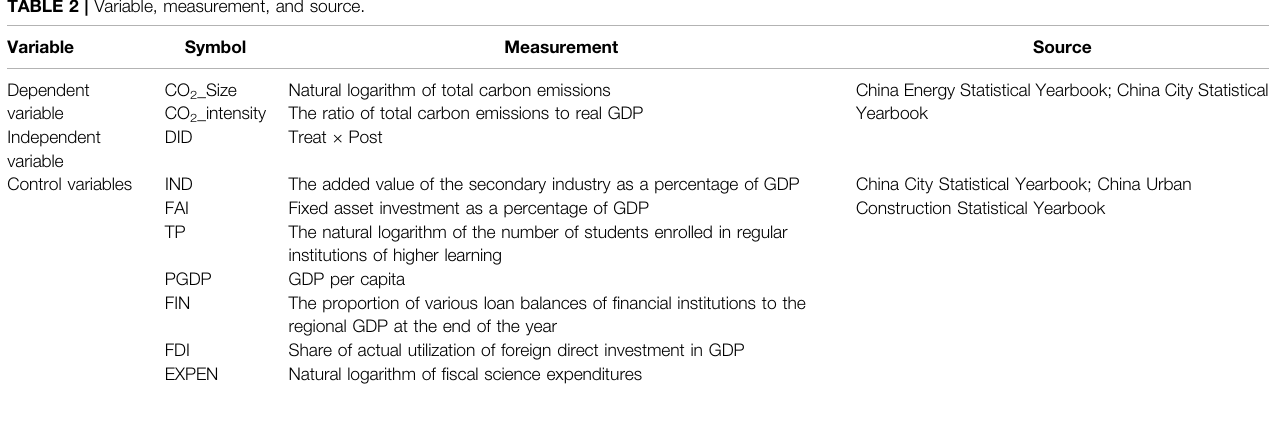
TABLE 2 | Variable, measurement, and